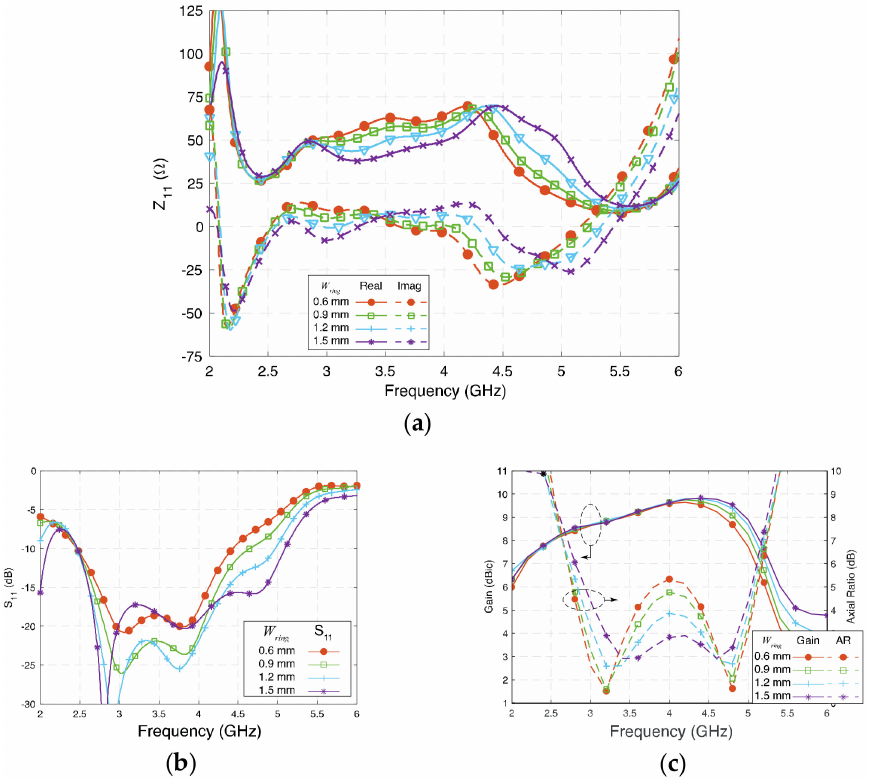
Figure 7. ( a ) Impedance (Z 11 ), ( b ) reflection coefficient (S 11 ), and ( c ) gain and axial ratio of the proposed antenna at different W ring